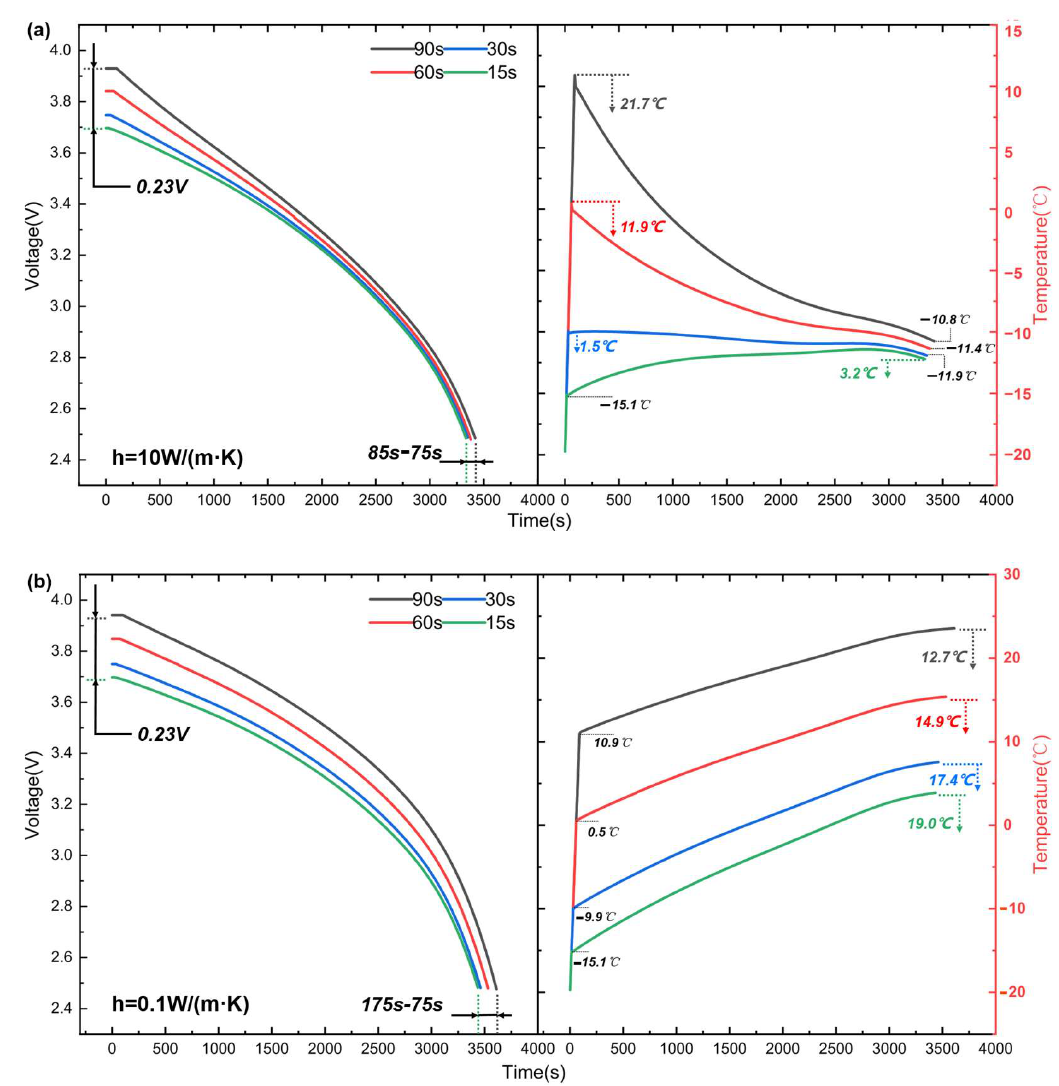
Figure 5. Voltage ( left ) and temperature curve ( right ) of 1C discharge at different heating times: ( a ) Without insulation; ( b ) With insulation.